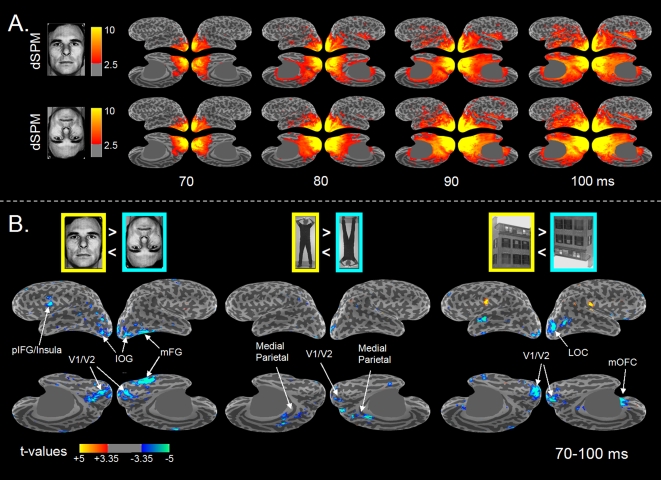
Source distribution of the M100 Stimulus Inversion Effect.A. Anatomically constrained source analysis (average dSPM values across subjects; n = 9) for Upright (top trace) and Inverted Faces (bottom trace) from 70–100-ms after stimulus onset visualized on the inflated cortical surface (gyri appear in light grey, sulci in dark grey). For each time-instant, four different views are presented to depict the whole cortical surface, with left hemisphere on the left and right hemisphere on the right of each quadruplet. The two top images of each quadruplet show the lateral aspects of the brain and a little strip of the ventral aspect (lateral view, 11° tilted towards the bottom view); the two bottom images show the medial and ventral aspects of the brain (medial view, 45° tilted towards bottom view). Only values of dSPM>2.5 are visualized. A grey opaque mask was placed over the midbrain. B. Differential activation related to the Inversion Effects, i.e. the contrast between the Upright and Inverted condition of Faces, Bodies and Houses. Displayed are the largest positive or negative t-values (two-tailed paired t-tests; n = 9; df = 8) at each dipole location occurring within the 70–100-ms time-window. Significant t-values at the level of p<0.01 are thresholded with respect to baseline noise and visualized only if the dipole strength exceeds a signal-to-noise ratio of 2.5 (i.e. dSPM>2.5) in at least one of the single stimulus conditions. The red and yellow colors denote locations at which the dipole strength is stronger for Upright than for Inverted stimuli. Blue colors denote locations in which the dipole strength is stronger for the Inverted stimuli. Absolute t-values of 3.35 and larger (red/dark-blue) correspond to p<0.01, absolute t-values of 4.8 and larger (yellow/light blue) to p<0.001. Abbreviations: mFG = middle Fusiform Gyrus; IOG = Inferior Occipital Gyrus; LOC = Lateral Occipital Cortex; pIFG = posterior Inferior Frontal Gyrus; mOFC = medial OrbitoFrontal Cortex.